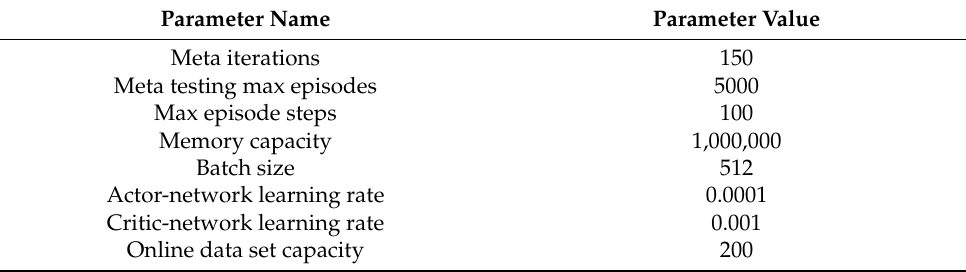
Figure 4. The structures of policy neural networks ( a ) and Q-value neural networks ( b ). Table 4. Parameters of meta-DDPG